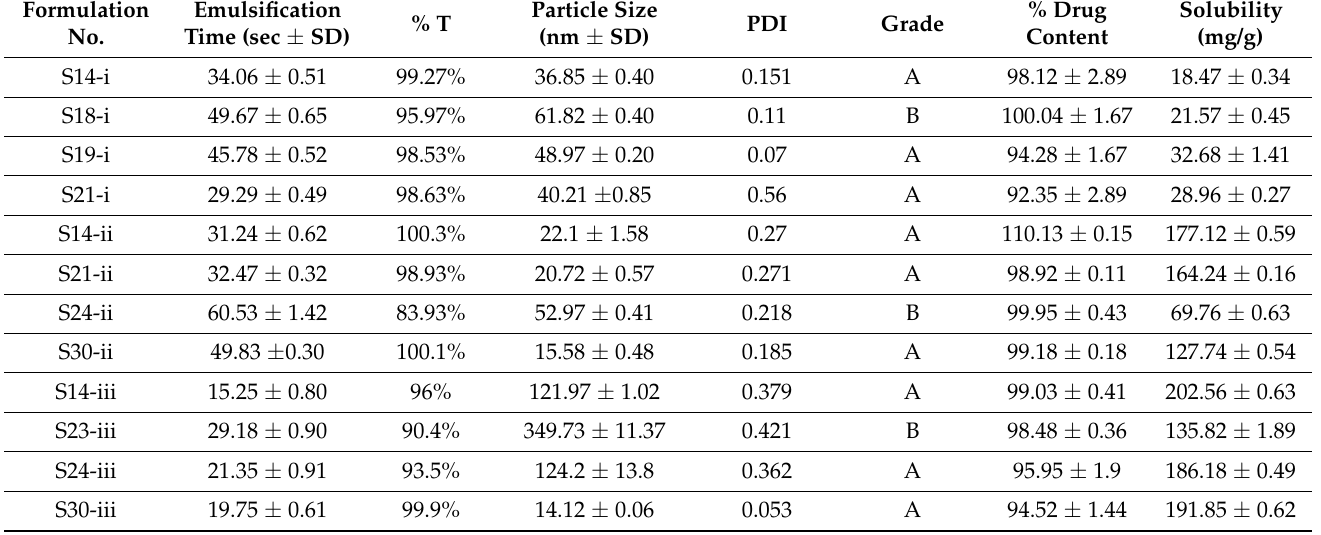
Table 3. Emulsification time, percentage of transmittance (% T), droplet size (PS), polydispersity index (PDI), dispersibility grade, percentage of drug content and PGZ solubility in selected liquid self-nanoemulsifying formulations (L-SNEDDS) for systems I, II and